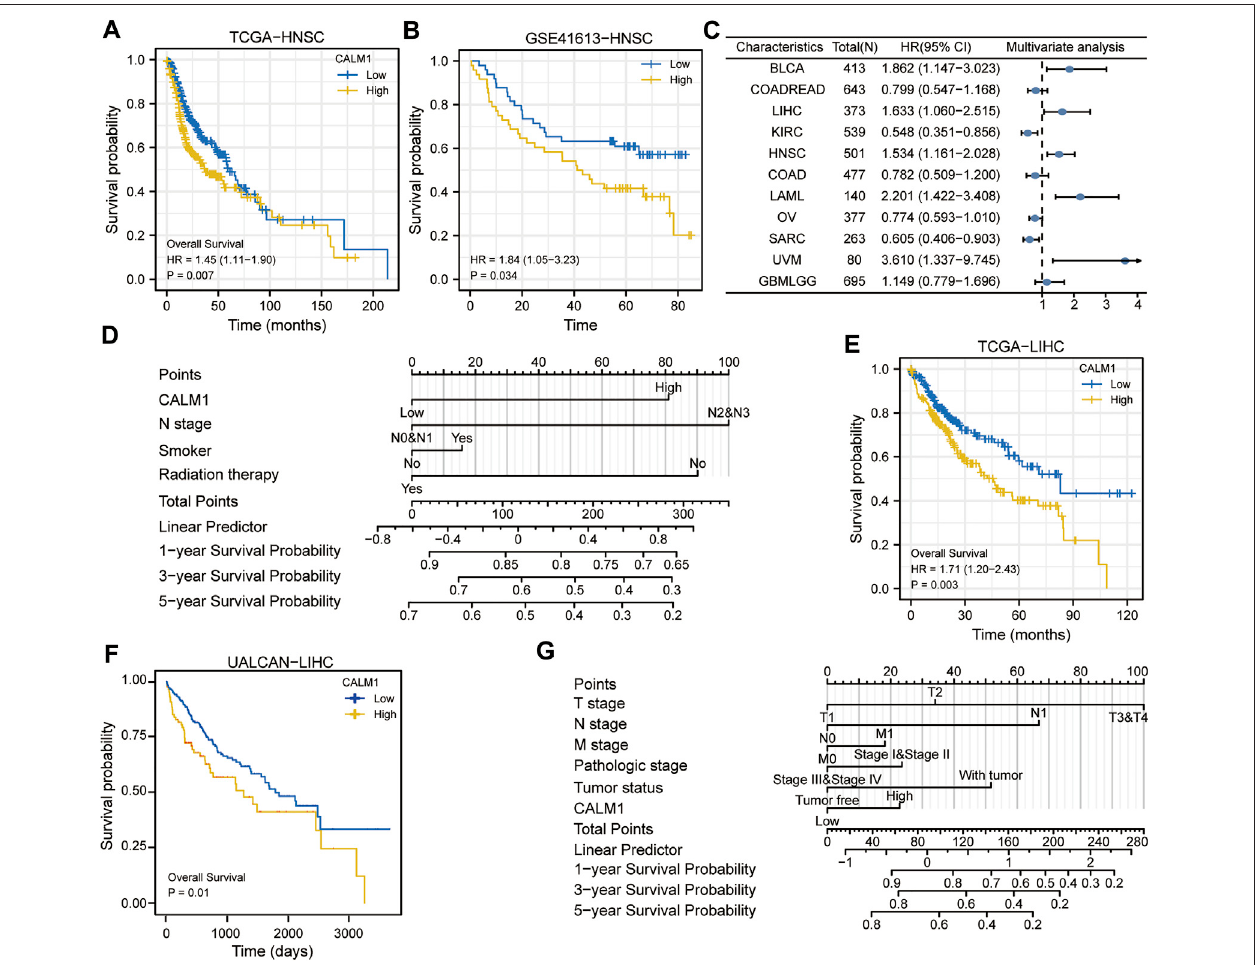
FIGURE 6 | Evaluation prognostic potential of CALM1 expression and establishment of nomograms in HNSC and LIHC. (A) Survival curves show that overall survival was different for patients with low or high expression of CALM1 in HNSC. (B) The GSE41613 dataset was used to verify the prognostic potential of CALM1 expression in HNSC. (C) Forest plot for the prognostic analysis of CALM1 expression in human cancers. (D) Construction of the nomogram model integrating CALM1 expression,Nstage,smoker,andradiationtherapyinHNSC. (E) Survivalanalysisshowpatientswithdecreased CALM1 expressionhadafavorableoverallsurvival inLIHC. (F) TheUALCANdatabasewasusedtoverifytheprognosticpotentialof CALM1 expressioninLIHC. (G) Constructionofanomogrammodelintegrating CALM1 expression, TNM stages, pathologic stages, and tumor status in LIHC. HNSC, head and neck squamous cell carcinoma; LIHC, liver hepatocellular carcinoma.